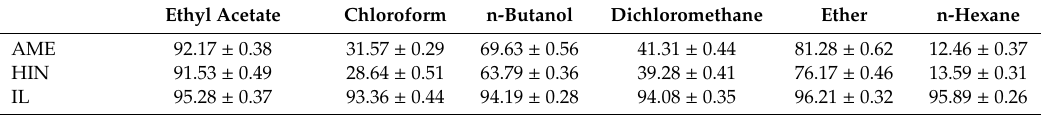
Figure 6. HPLC-DAD chromatograms of recovery sample from S. sinensis ( a ) and [C 6 mim]BF 4 standard ( b ). Figure 7. Performance of recovered [C 6 mim]BF 4 on the yields of AME and HIN.